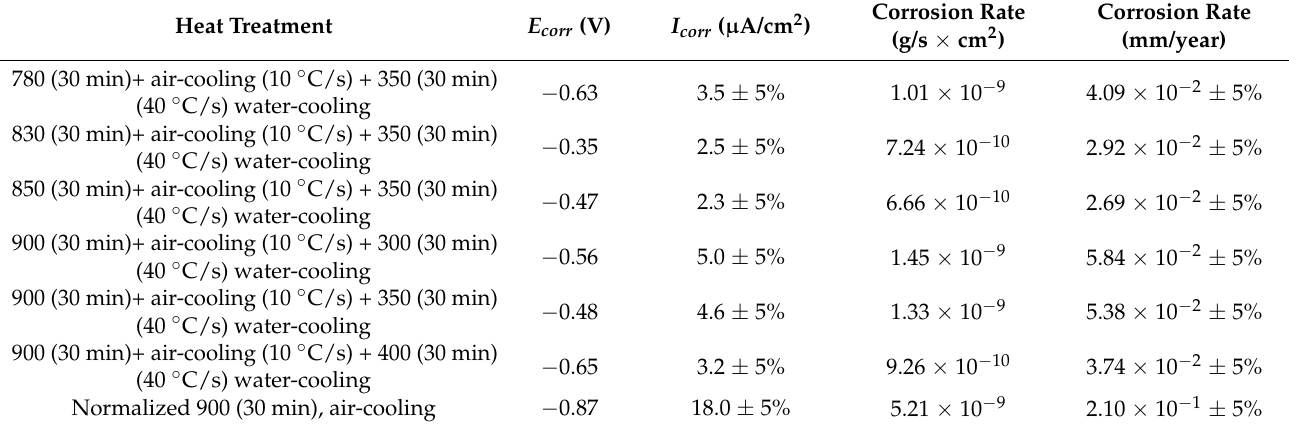
Table 4. Values of corrosion potential and corrosion current densities graphically extrapolated form Figures 10a and 11a. Corrosion rates calculated with Equation (1) are also reported in the last two columns.